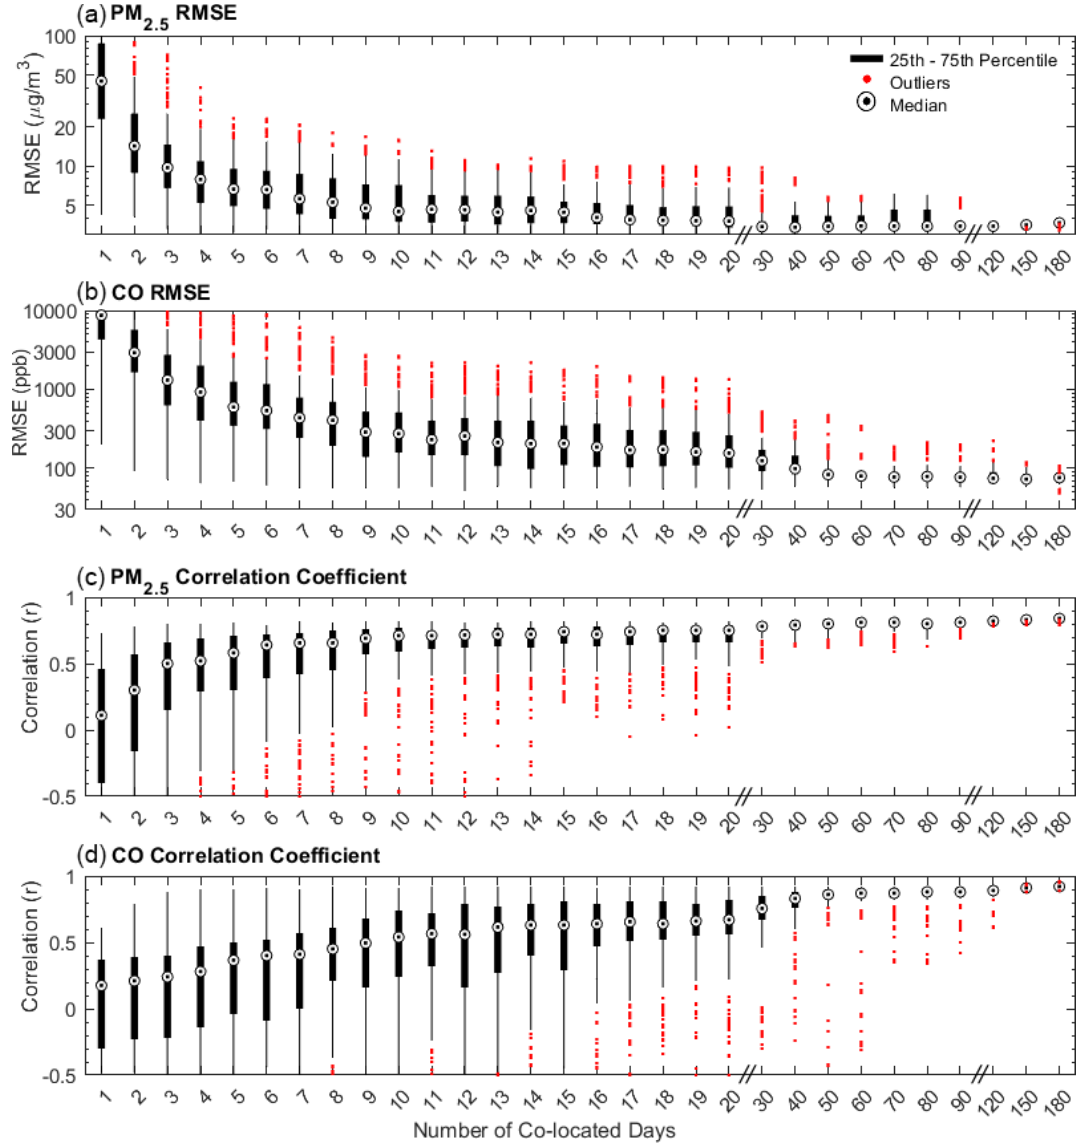
Figure 1. The potential range of the (a,b) RMSE and (c,d) correlation coefficients ( r ) for a given co-location length for the low-cost PM 2 . 5 and CO sensors. A calibration length of 1d indicates that a random, continuous 24h period was selected out of all available days. The RMSE for a given sample calibration was determined by comparing the 1h averaged reference and corrected sensor data from the days during the evaluation period (i.e., all other days of the year not used in the calibration). For each calibration length tested, 250 sample calibration periods were used to assess the range of potential RMSE and correlation coefficient values. All sensors were calibrated using previously identified predictors in a multiple linear regression using data from the calibration period only. Reference PM 2 . 5 concentrations ranged between 1 and 53µgm − 3 , with a median concentration of 7µgm − 3 , and reference CO concentrations ranged between 100 and 2947ppb, with a median concentration of